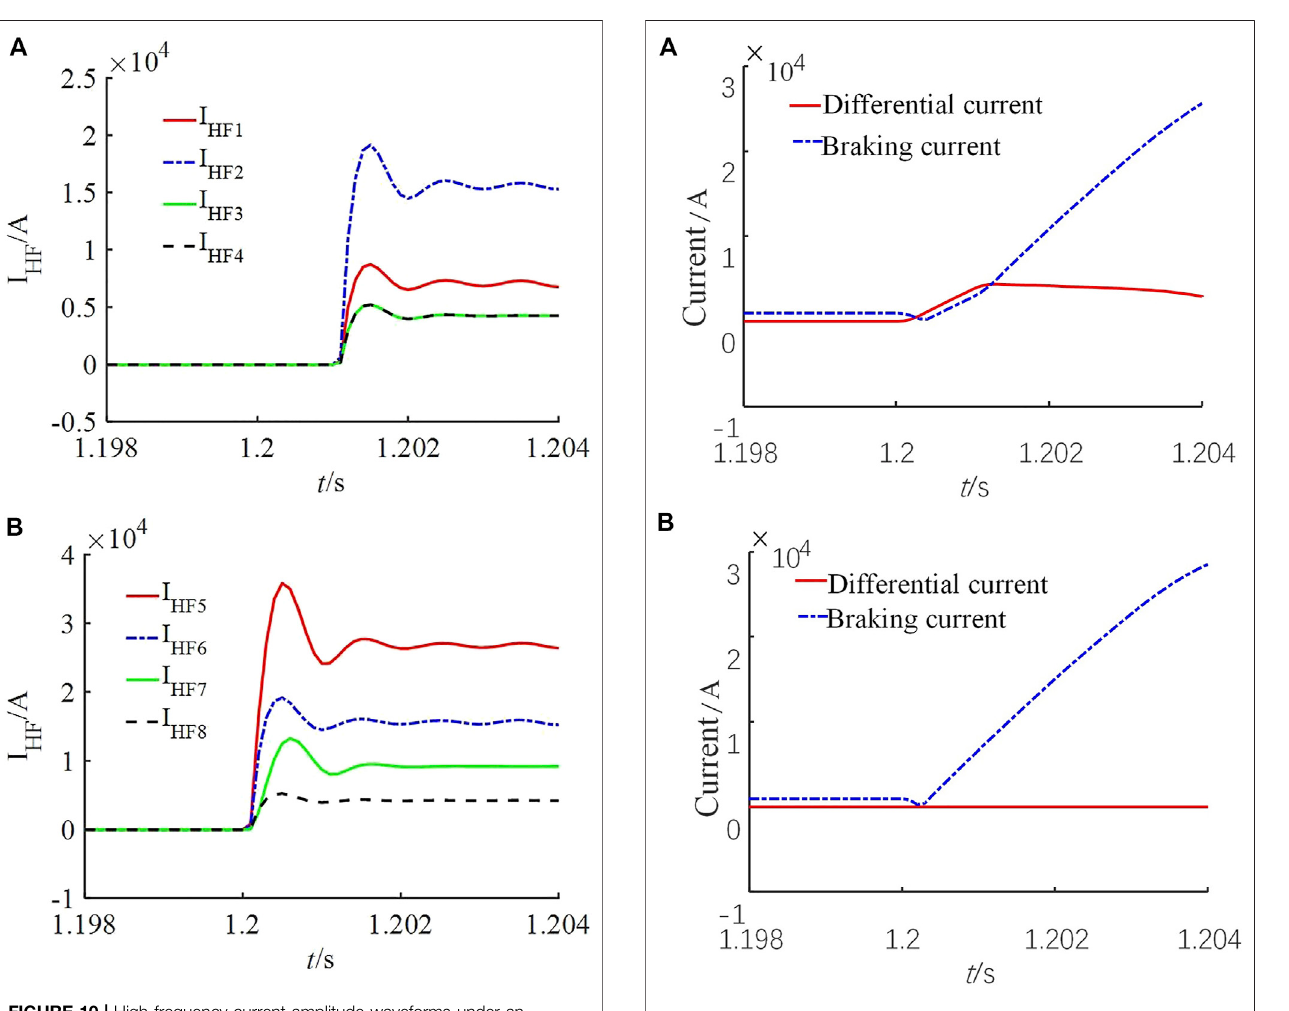
an external fault (A) Without data synchronization (B) With data